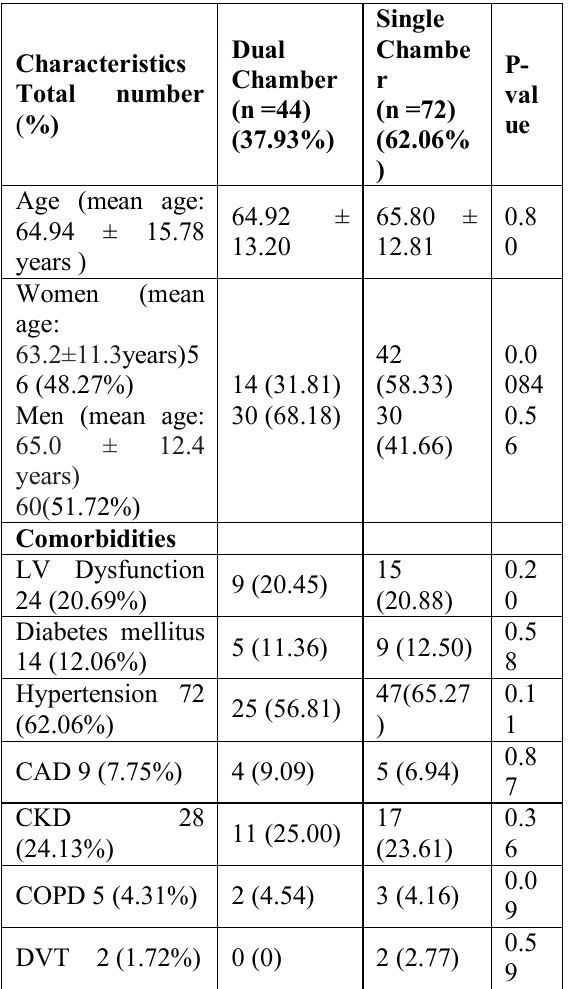
Table 2: Univariate analysis of